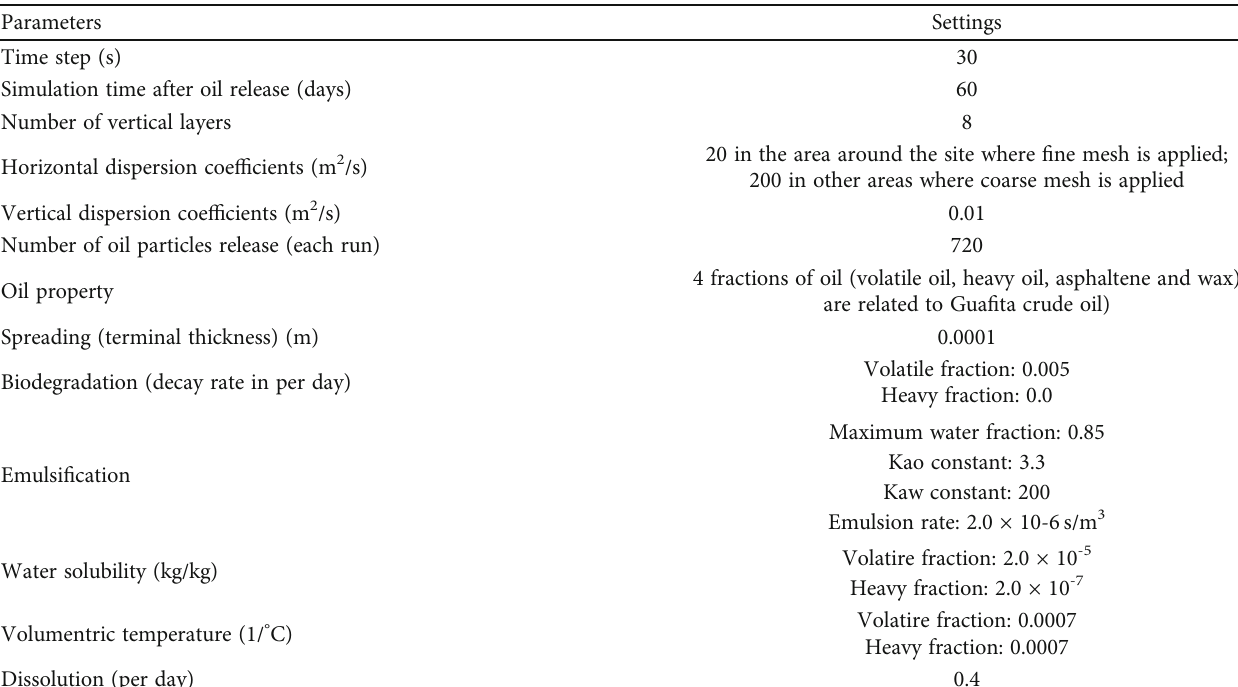
Figure 10: Weathering processes of oil in marine environmental in open Table 2: Model setup main parameters.